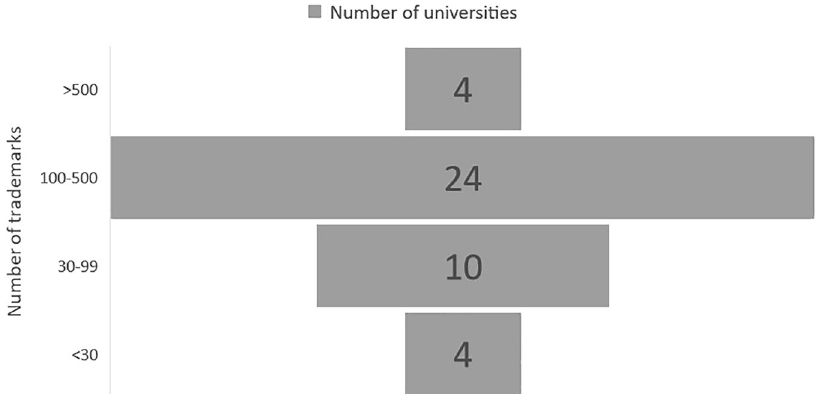
Fig. 3 Distribution of the 42 fi rst-class universities ’ trademarks. With small ends and a large middle, the overall distribution resembled an “ olive